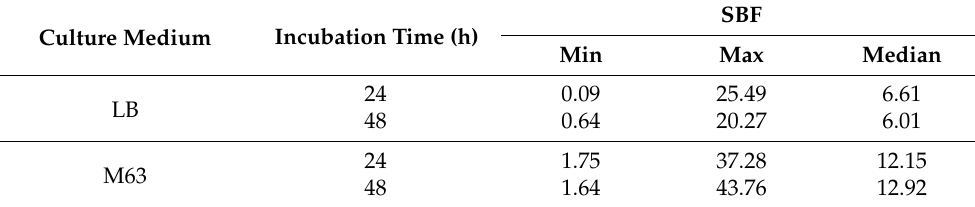
Table 3. Distribution of SBF values of 78 equine A. baumannii isolates in LB and M63. Culture Medium